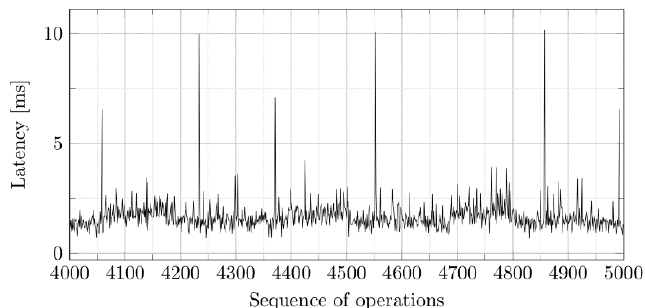
Figure 14. Sequence of latency values measured within the fifth group of one thousand operations.